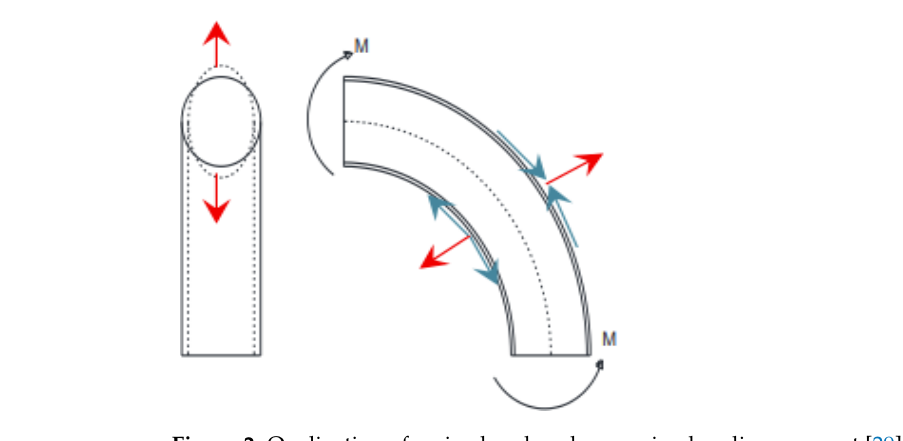
Figure 2. Ovalization of a pipe bend under opening bending moment [29].